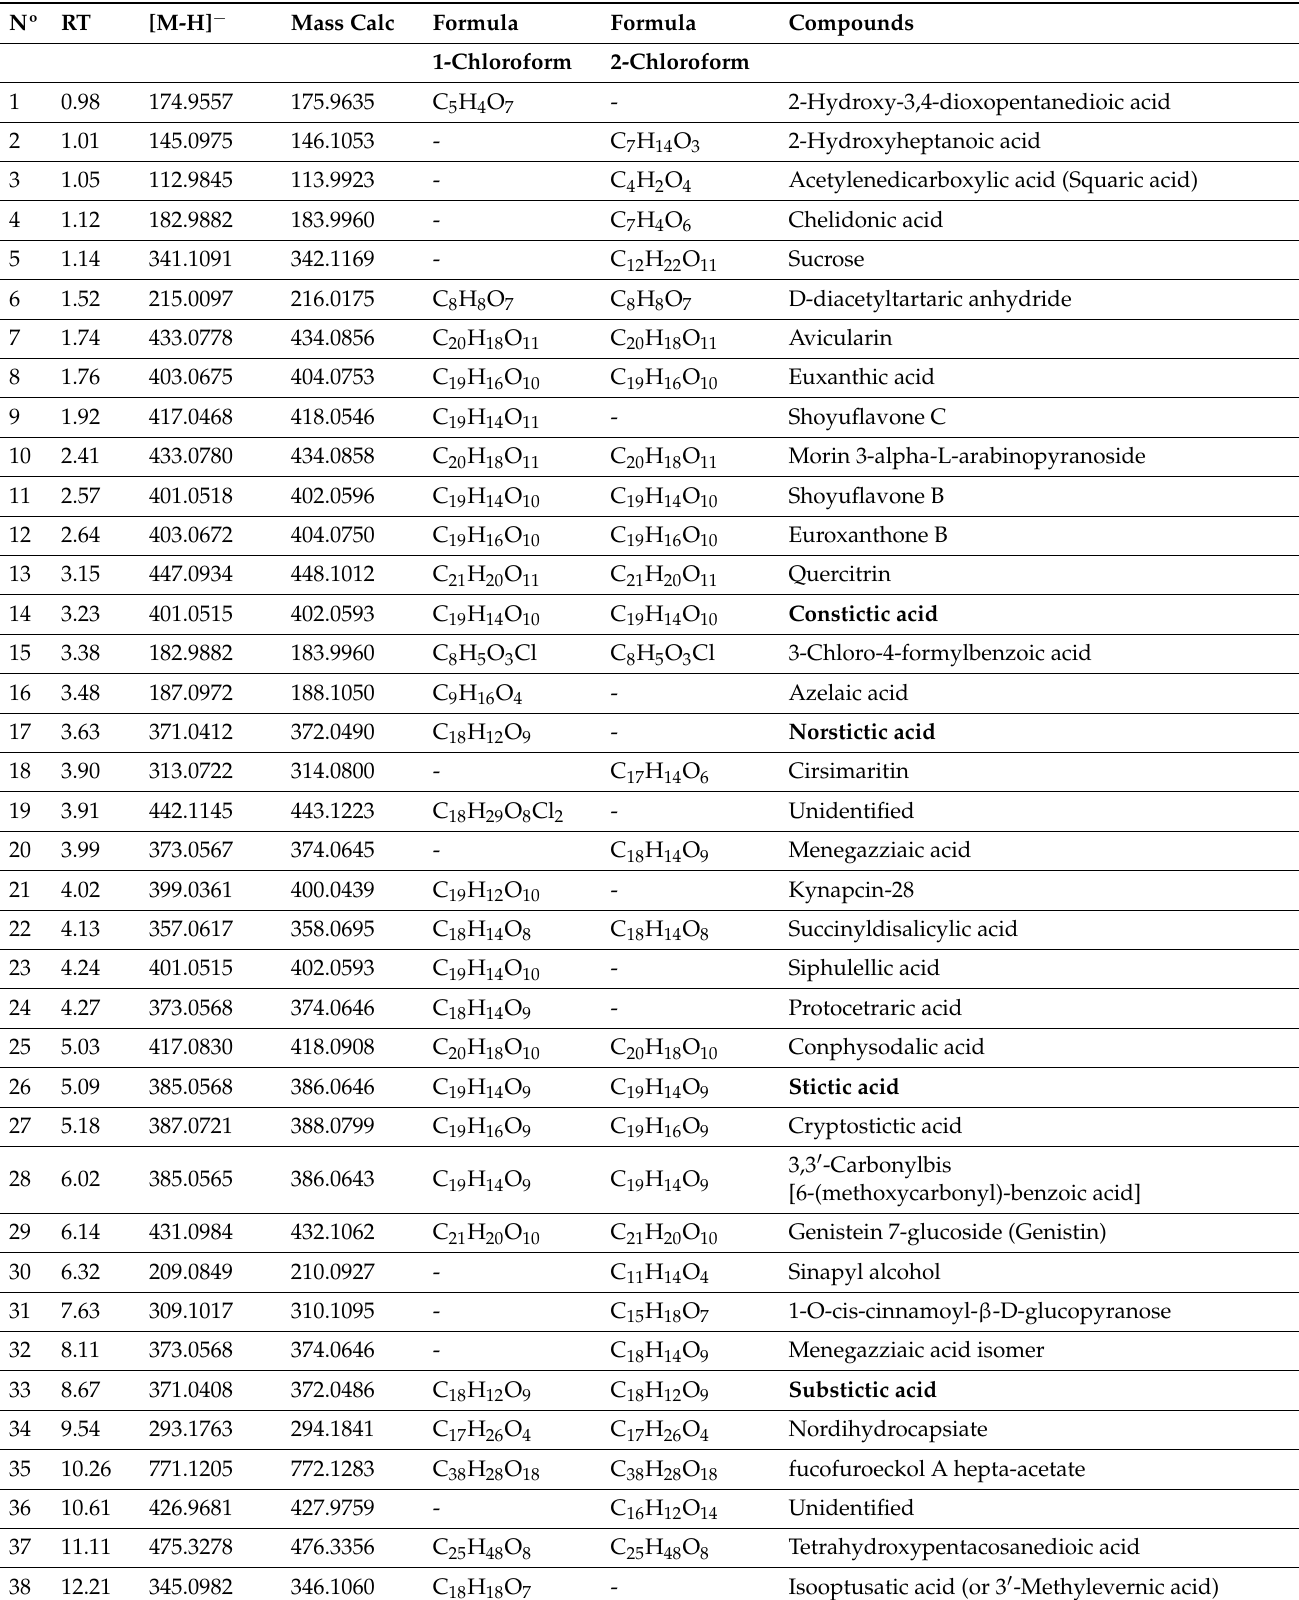
Table 7. Samples Parmotrema hypoleucinum (in Olea europea ), Chloroform extract, 1-Chloroform